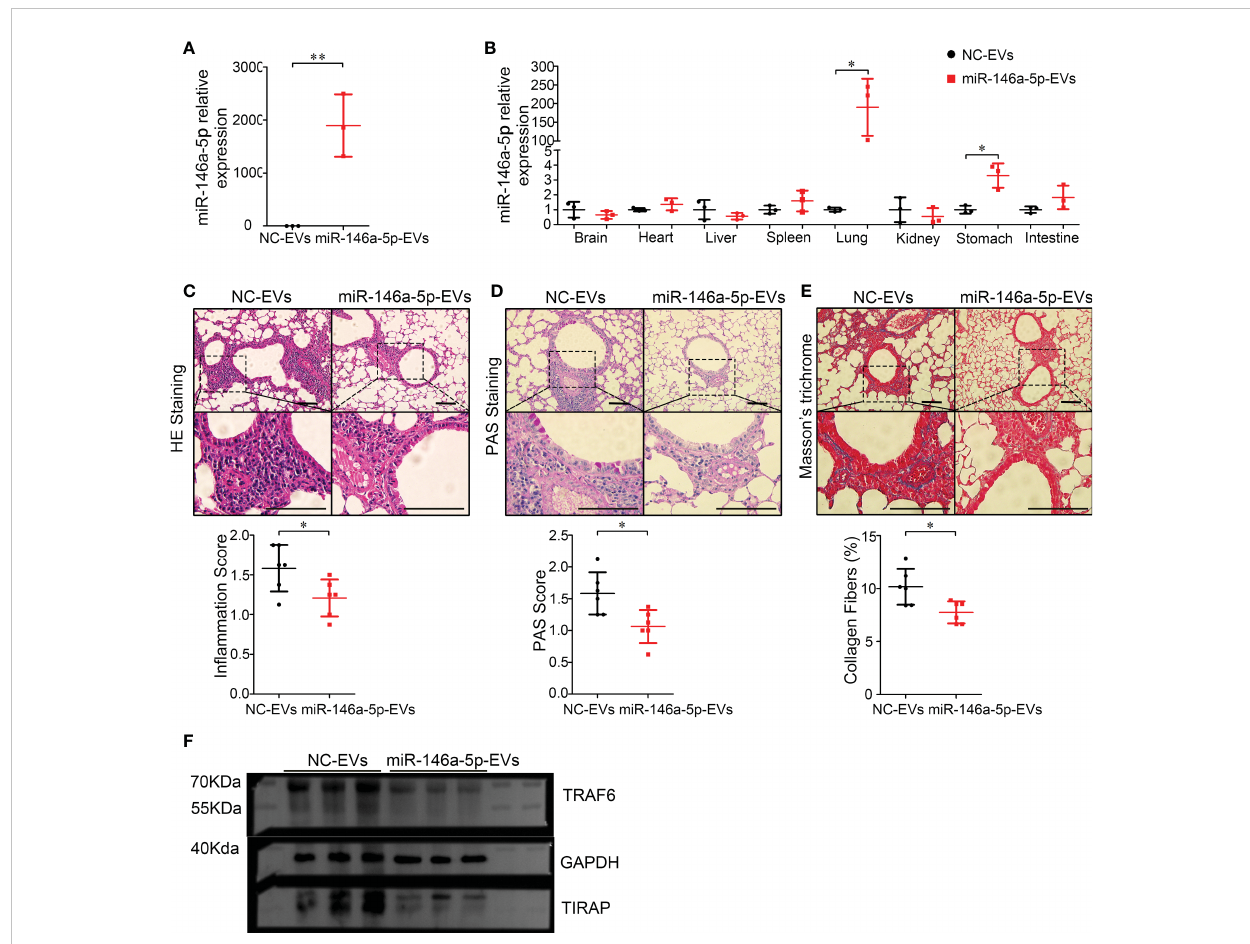
FIGURE 7 Inhalation of Hypo-EVs carrying miR-146a-5p (miR-146a-5p-EVs) more inhibited airway in fl ammation and remodeling in chronic asthma mice. (A) Relative miR-146a-5p levels in miR-146a-5p-EVs and NC-EVs were detected by real-time PCR (n=3). (B) Levels of miR-146a-5p in major organs (brain, heart, liver, spleen, lung, kidney, stomach, and intestines) following administration by aerosol miR-146a-5p-EVs and NC-EVs (n=3). Representative photographs of HE (C) , PAS (D) , and Masson trichrome (E) stained lung sections from each group (black bar = 100 m m), the images are shown at ×200 (up panel) and ×400 (down panel), and respectively in fl ammatory score, PAS score and and the percentage of collagen fi ber content in airway were quanti fi ed (n=6). (F) The protein levels of TRAF6 and TIRAP in the lung samples were analyzed by western blot, and the GAPDH was as a loading control (n=3). Each dot represents data from one animal. Student ’ s t-test: * P < 0.05, ** P <